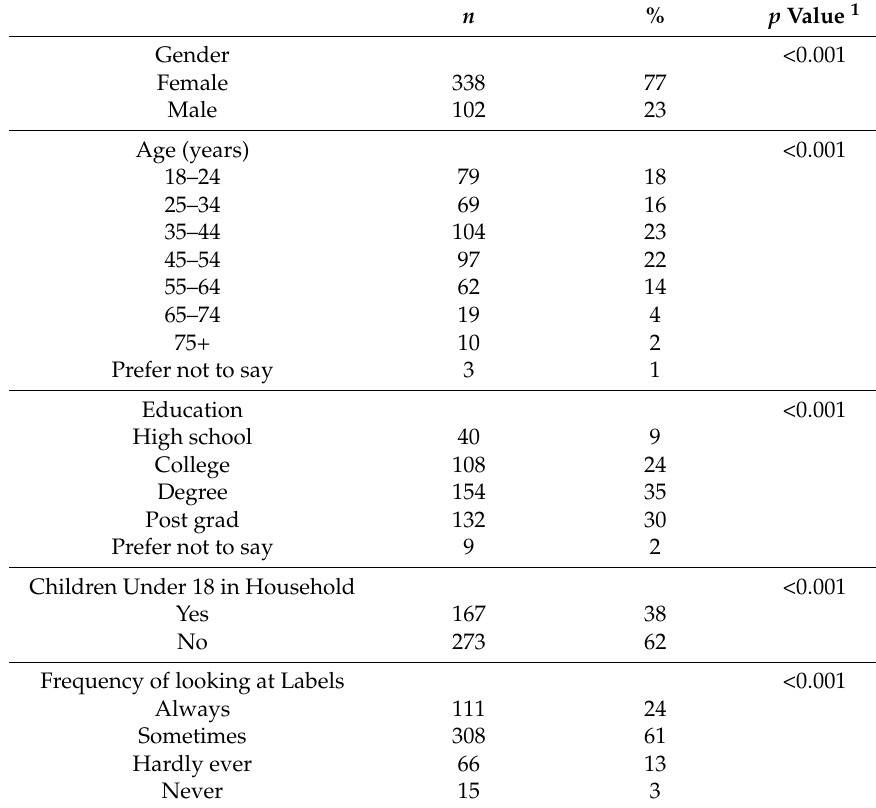
Table 2. General characteristics of